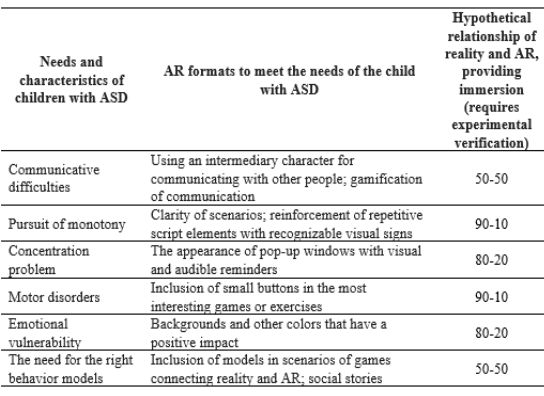
Table 1. AR formats and children with